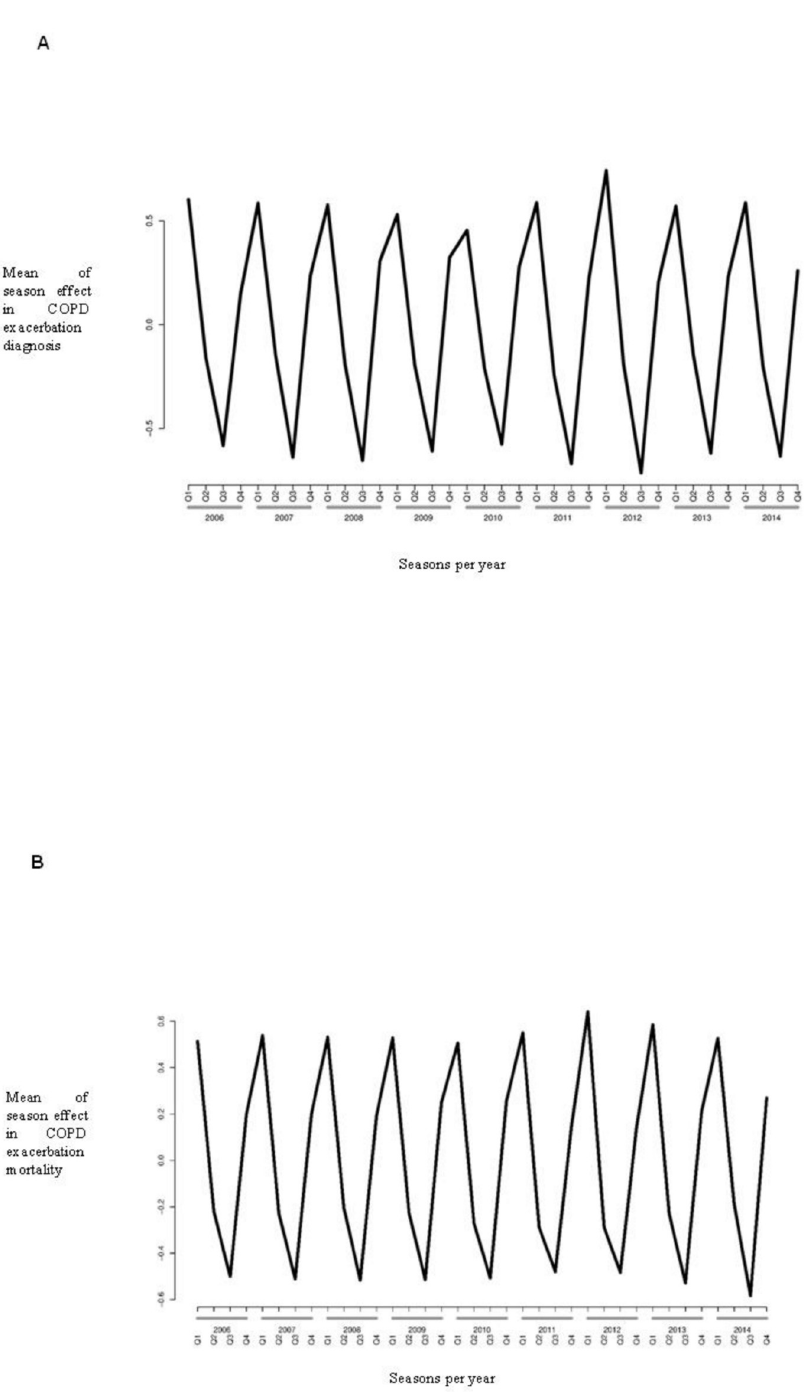
Fig 1. Mean of the seasonal effect in admissions for COPD exacerbation (A) and in-hospital mortality (B) in Spain between 2004 and 2013.